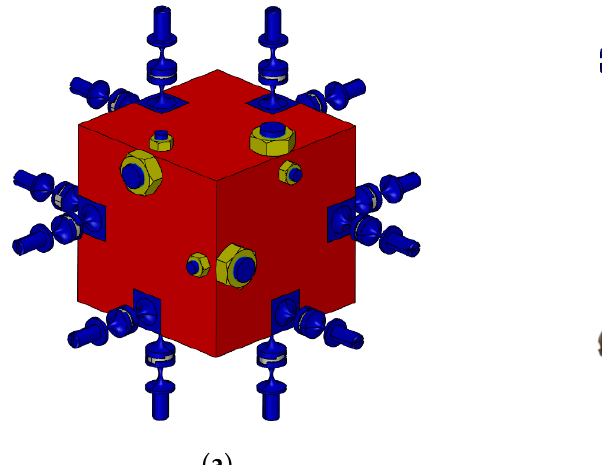
Figure 3. ( a ) Configuration scheme of the branch chain combination; ( c ) Structure model of a branch chain; ( b ) Physical prototype of a branch chain.